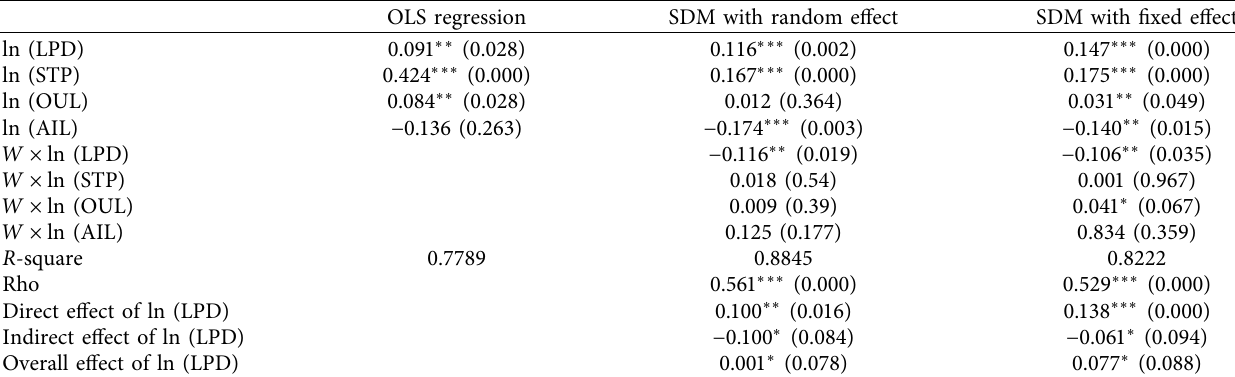
Table 6: Regression estimation results of the three